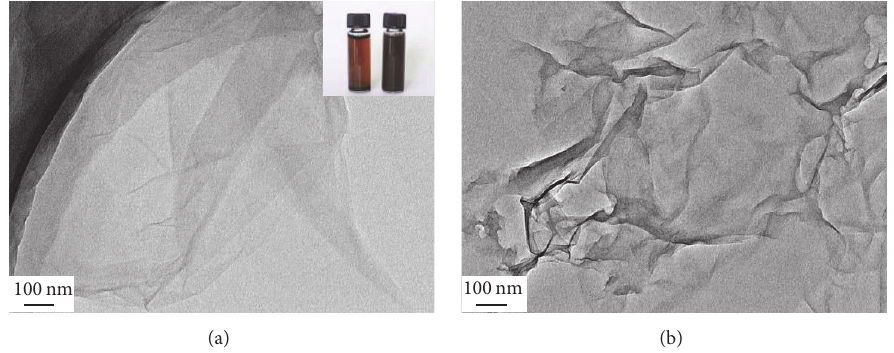
Figure 3: TEM images of (a) GO and (b) alkylated- grafted -GO (aGO).